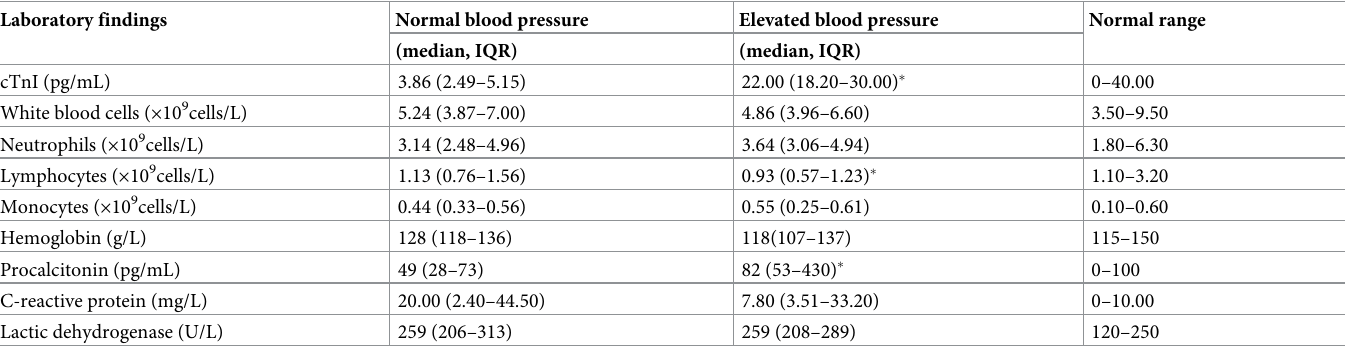
Table 4. The laboratory findings of patients with or without elevated blood